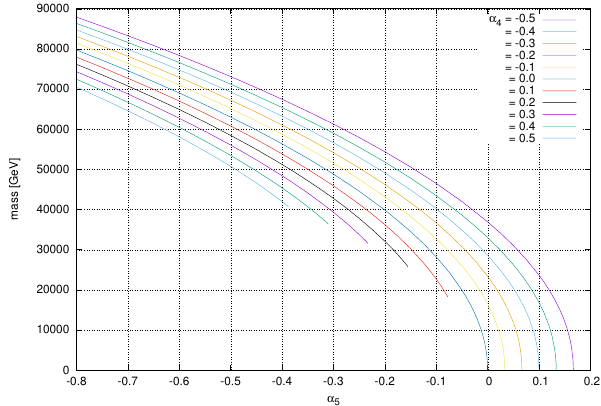
Figure 4 . Mass of the EW-Skyrmion for the case that no scalar (cid:12)eld is included. The mass is plotted as functions of (cid:11) 5 for various choices of (cid:11) 4